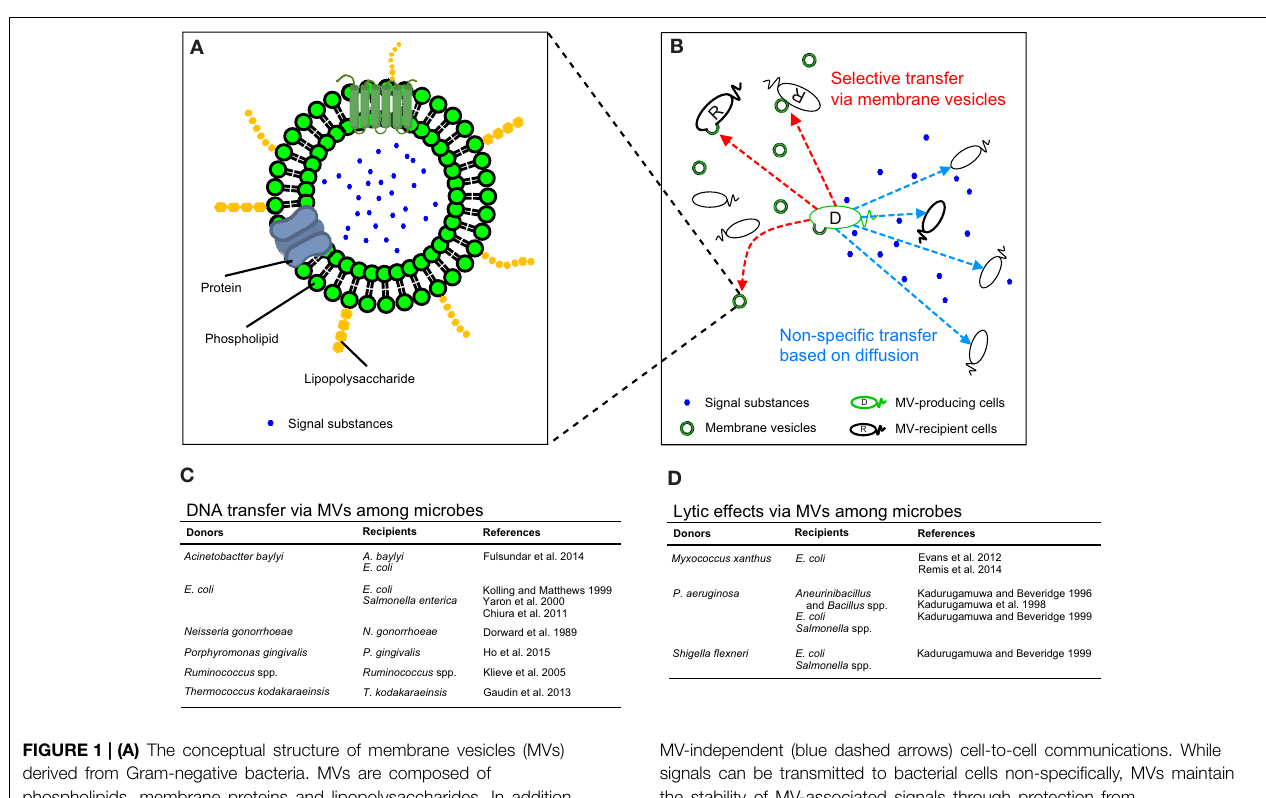
FIGURE 1 | (A) The conceptual structure of membrane vesicles (MVs) derived from Gram-negative bacteria. MVs are composed of phospholipids, membrane proteins and lipopolysaccharides. In addition, various kinds of substances including DNA, exoproteins and quorum-sensing signals are contained in or are associated with MVs. (B) The pattern diagram of MV-mediated (red dashed arrows) and